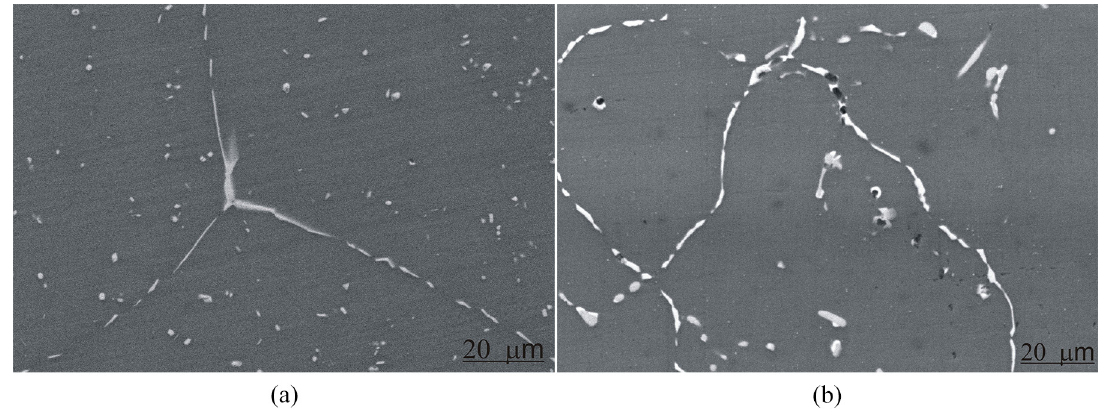
Figure 9. Annealed microstructures of Al‑9%Zn‑3.5%Mg (а) and Al‑9%Zn‑3.5%Mg‑0.5%Ca; (b) alloys after slow cooling (Vc~0, 1 K s –1